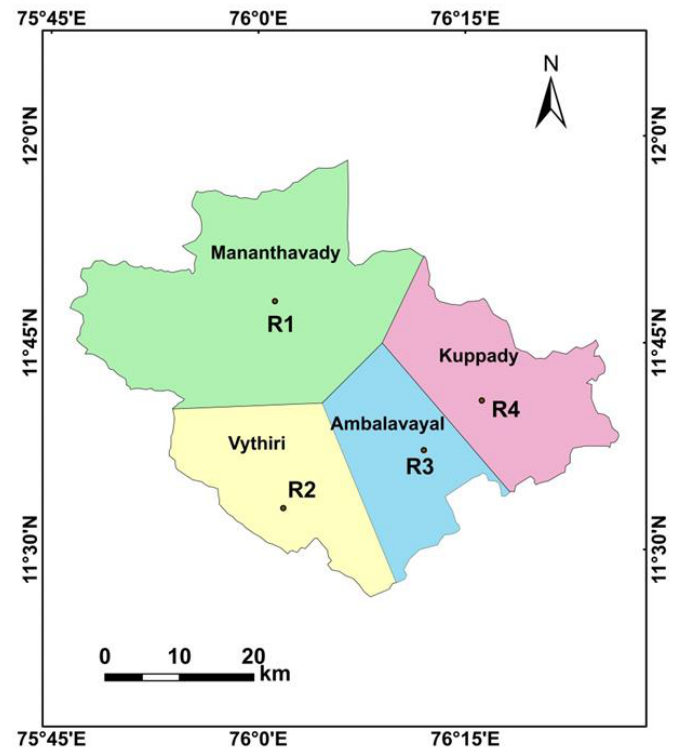
Figure 6. Location of rain gauges and definition of their area of influence based on nearest rain gauge.